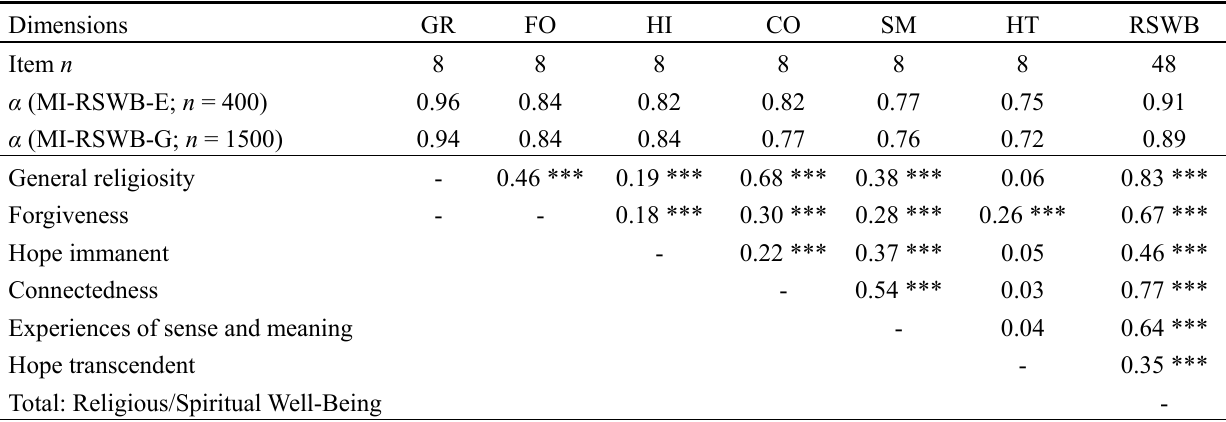
Table 2. Internal consistencies (Cronbach’s α ) and inter-correlations for the MI-RSWB-E subscales and the total